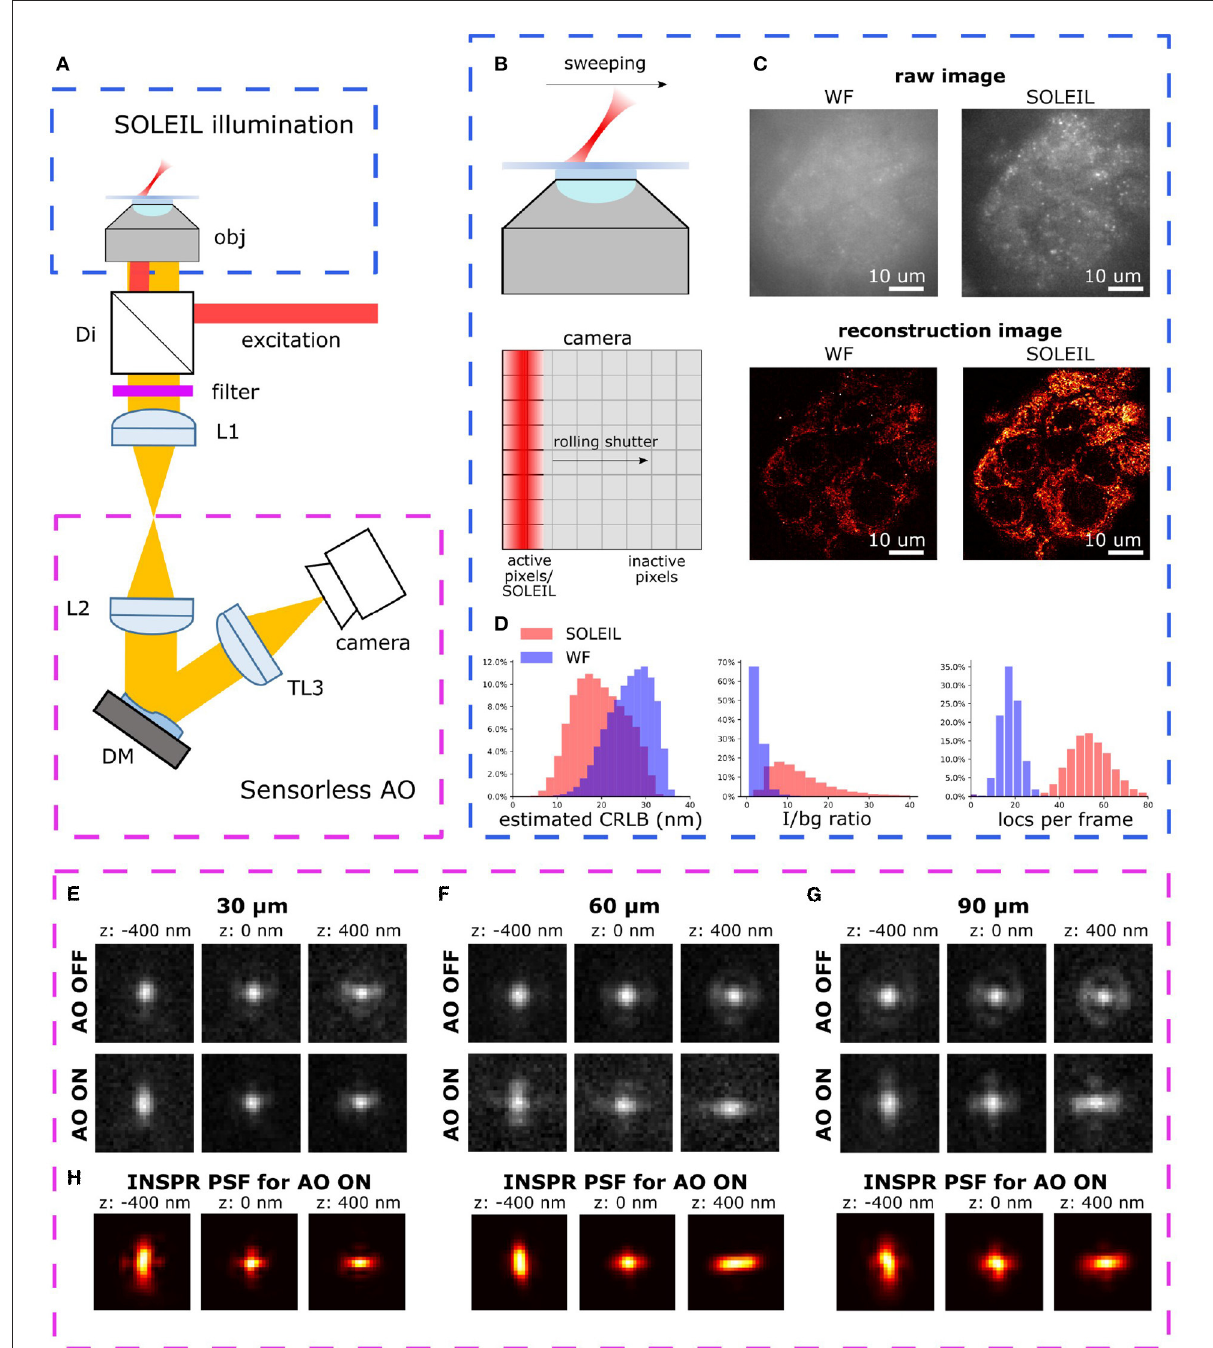
FIGURE1 (A) Optical setup of AO-SOLEIL microscopy. obj: objective lens, Di: dichroic mirror, filter: emission filter, L1 to L3: achromatic doublet lens, DM: deformable mirror, camera: sCMOS camera. For the details of system, see Supplementary Section 1. (B) Working principle of SOLEIL and camera readout. The camera readout is synchronized with the SOLEIL illumination area (red). The SOLEIL illumination is controlled by a galvo mirror. (C) Demonstration of SOLEIL background reduction (dSTORM) on spheroid Caco2-BBE cells (mitochondria). upper row: raw camera image by widefield and SOLEIL microscopy (equal contrast). lower row: SMLM reconstructions. (D) Comparison between WF and SOLEIL of estimated lateral CRLB, I/bg ratio, and number of localization per frame (loc per frame). (E–G) The astigmatism PSF before (AO OFF) and after (AO ON) AO correction at different imaging depth (30, 60, and 90 µ m). The PSFs were acquired by imaging 23 nm fluorescence beads (Thermo Fisher Scientific, Tetraspeck) embedded in 1 % agarose gel. The emission wavelength is 680 nm. (H) The estimated in-situ PSF models using the INSPR